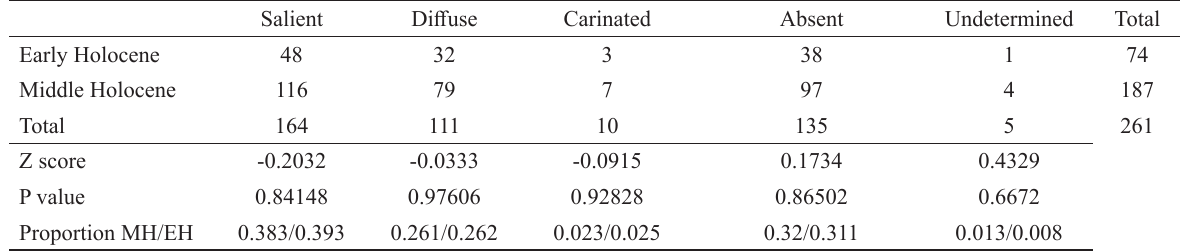
Bulb types from Early and Middle Holocene Holocene flakes.